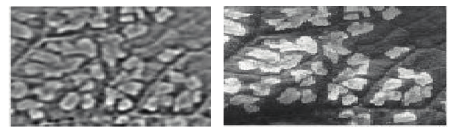
Figure 4: Tan–Triggs normalization.